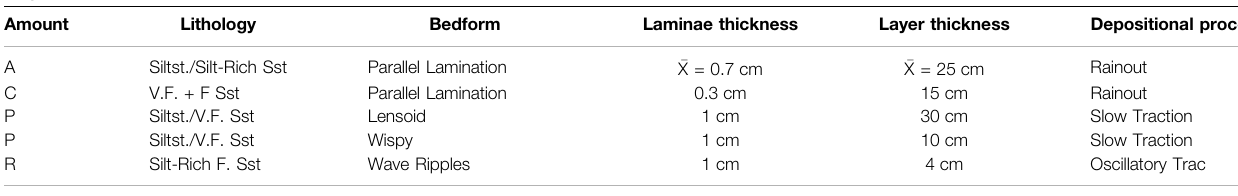
TABLE 2 | Middle coarsening upward